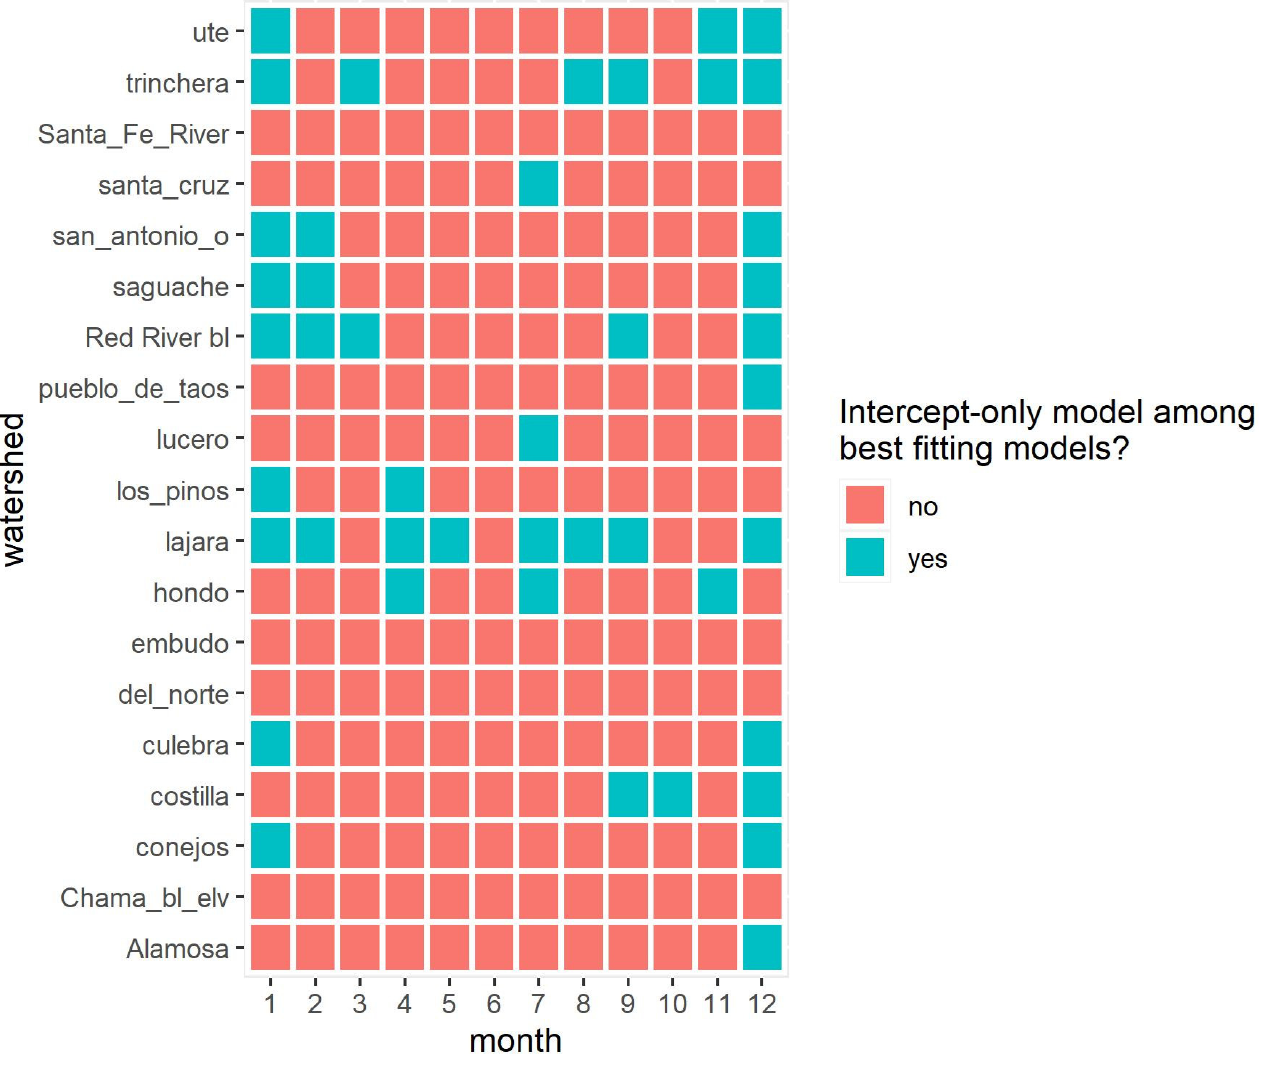
Figure 6. “Intercept-only” model for month and watershed